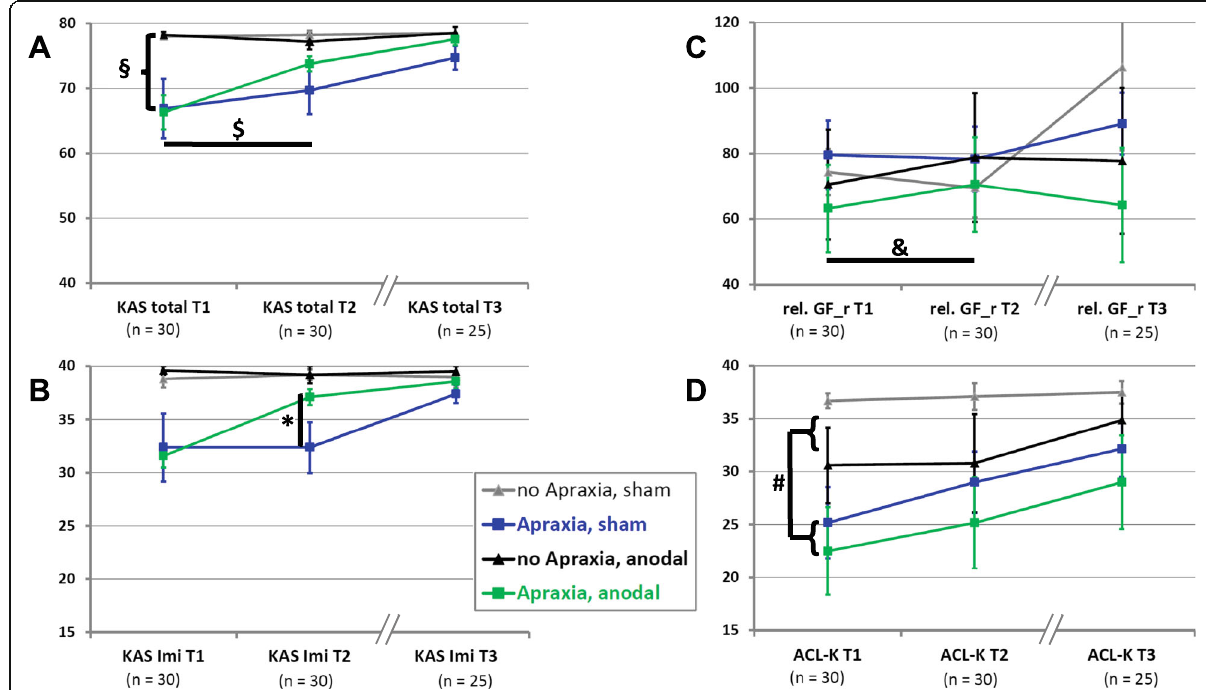
Fig. 3 Graphical illustration of the Cologne Apraxia Screening (KAS) total score ( a , upper, left panel), the KAS imitation subscore ( b , lower, left panel), the relative grip force of the contra-lesional, right hand ( c , upper, right panel), and the scores of the short version of the Aphasia Check- List (ACL-K, d , lower, right panel) in the four patient groups with LH stroke across the three assessments (baseline assessment [T1, n = 30], post- stimulation assessment [T2, n = 30], and follow-up assessment [T3, n = 25]). LH stroke patients with apraxia (squares) undergoing anodal tDCS (green, A+ anodal) or sham tDCS (blue, A+ sham), LH stroke patients without apraxia (triangles) undergoing anodal tDCS (black, A- anodal) or sham tDCS (grey, A- sham). Displayed are the means and the standard error of the mean (SEM). a . Apraxic patients scored significantly lower on the KAS than patients without apraxia (§, significant main effects of APRAXIA F (1,26) = 6.6, p < .05). Furthermore, there was a significant interaction APRAXIA by TIME ($, F (1,26) = 6.7, p < .05), indicating that the KAS total scores of apraxic patients (KAS total score at baseline: 66.7 ± 12.1, KAS total score at post-stimulation: 71.6 ± 9.3) improved significantly more from baseline to post-stimulation than those of the non-apraxic patients (KAS total score at baseline: 78.1 ± 8.8, KAS total score at post-stimulation: 77.7 ± 2.2; t (28) = − 2.4, p < .05). b . For the scores of the imitation subtests of the KAS (KAS imi), the asterix (*) indicates the significant 3-way-interaction APRAXIA by TIME by STIMULATION (F (1,26) = 4.6, p < .05): The KAS imitation scores (maximum of 40 points) of apraxic patients who underwent anodal tDCS (green squares) improved significantly more from baseline to post-stimulation (from 31.6 ± 3.3 to 37.1 ± 2.3 points) than those of the apraxic patients undergoing sham tDCS (blue squares, from 32.4 ± 10.6 to 32.4 ± 7.9 points; t (18) = − 2.8, p < .05), while there was no significant modulation by stimulation nor relevant changes with time for the non-apraxic patients (non-apraxic, anodal [black triangles]: 39.6 ± 0.9 to 39.2 ± 1.8 points; non-apraxic, sham [grey triangles]: 38.8 ± 1.8 to 39.2 ± 1.1 points; t (8) = 0.65, p = 0.535). c . Independent of apraxia, there was a significant interaction TIME by STIMULATION (&, F (1,26) = 4.9, p < .05), indicating that the grip force levels of the contralesional, right hand significantly improved from baseline to post-stimulation in the stroke patients who underwent anodal tDCS, while no relevant changes were observed for the sham group (anodal tDCS group [green and black lines]: from 65.8 ± 37.9% to 73.5 ± 42.1%; sham tDCS group [blue and grey lines]: from 77.9 ± 29.7% to 75.6 ± 29.1%). Rel. GF_r = relative grip force of the contra-lesional right hand (in relation to the ipsi-lesional left hand, in %). d . There were no significant differential effects of tDCS on the ACL-K-scores, but a main effect of APRAXIA (#, F (1,26) = 4.6, p < .05), which indicated more severe aphasic deficits in the apraxic patients (squares, 25.5 ± 11.5) compared to patients without apraxia (triangles, 33.8 ± vs. post-stimulation assessment). This ANOVA revealed To evaluate whether the improvements of apraxia that - irrespective of the presence/absence of apraxia - scores (as a marker for stroke-related motor- cognitive grip force levels of the contra lesional right hand signifi- deficits assessed with the ipsi-lesional, left hand) are par- cantly improved from baseline to post-stimulation in the alleled by changes in basic motor functions after stroke stroke patients who underwent anodal tDCS, while no (here: grip force levels of the contra-lateral, right hand), changes were observed for the sham group (anodal tDCS we computed for the grip force measures of the con- group: from 65.8 ± 37.9% to 73.5 ± 42.1%, t (13) = − 2.52, tralesional, right hand (normalized by the grip force of p < .05; sham tDCS group: from 77.9 ± 29.7% to 75.6 ± the ipsilesional, left hand to account for pre-existing in- 29.1%, t (15) = 0.95, p > .3; significant interaction TIME dividual differences in muscle strength) an ANOVA with by STIMULATION: F (1,26) = 4.9, p < .05, Fig. 3c). This the factors APRAXIA (apraxic vs. non-apraxic), STIMU- finding indicates a facilitatory effect of anodal tDCS on LATION (anodal vs. sham tDCS), and TIME (baseline